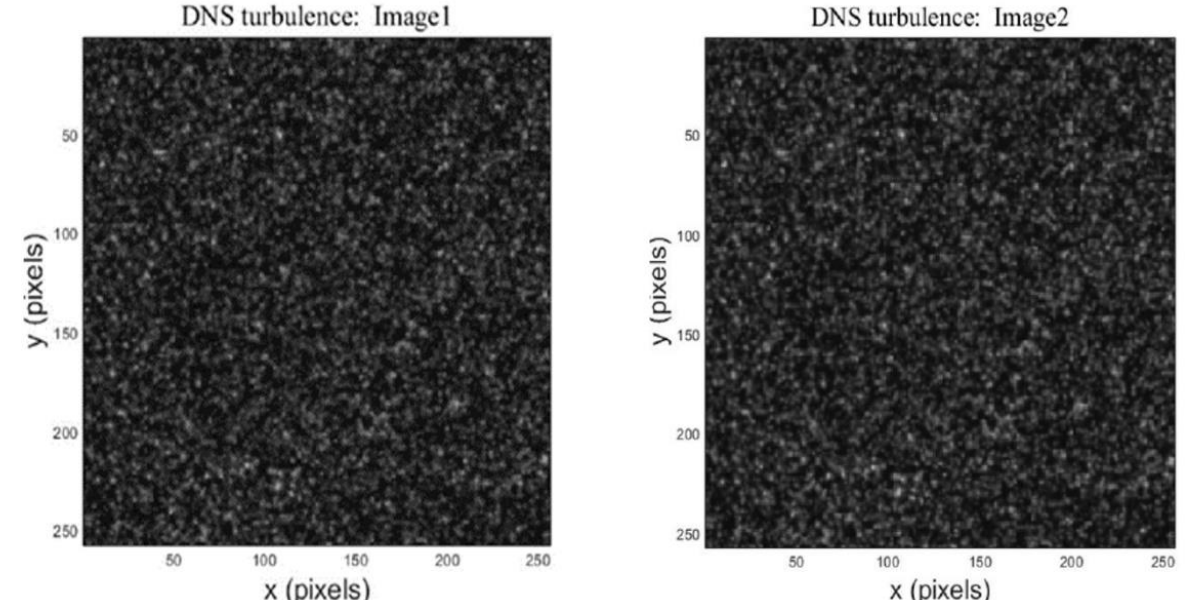
Figure 5. The curves of AEE (average endpoint error) for different optical flow methods (Horn – Schunck [8], Physics-based Flow [38], LAP-Flow [40], Split-Bregman Flow [41], SegFlow [42], TV- Wavelet Flow [39], PIV-RAFT [11], PIV-LiteFlowNet [10], DCN-Flow) on the 100 successive images of DNS-turbulent flow.